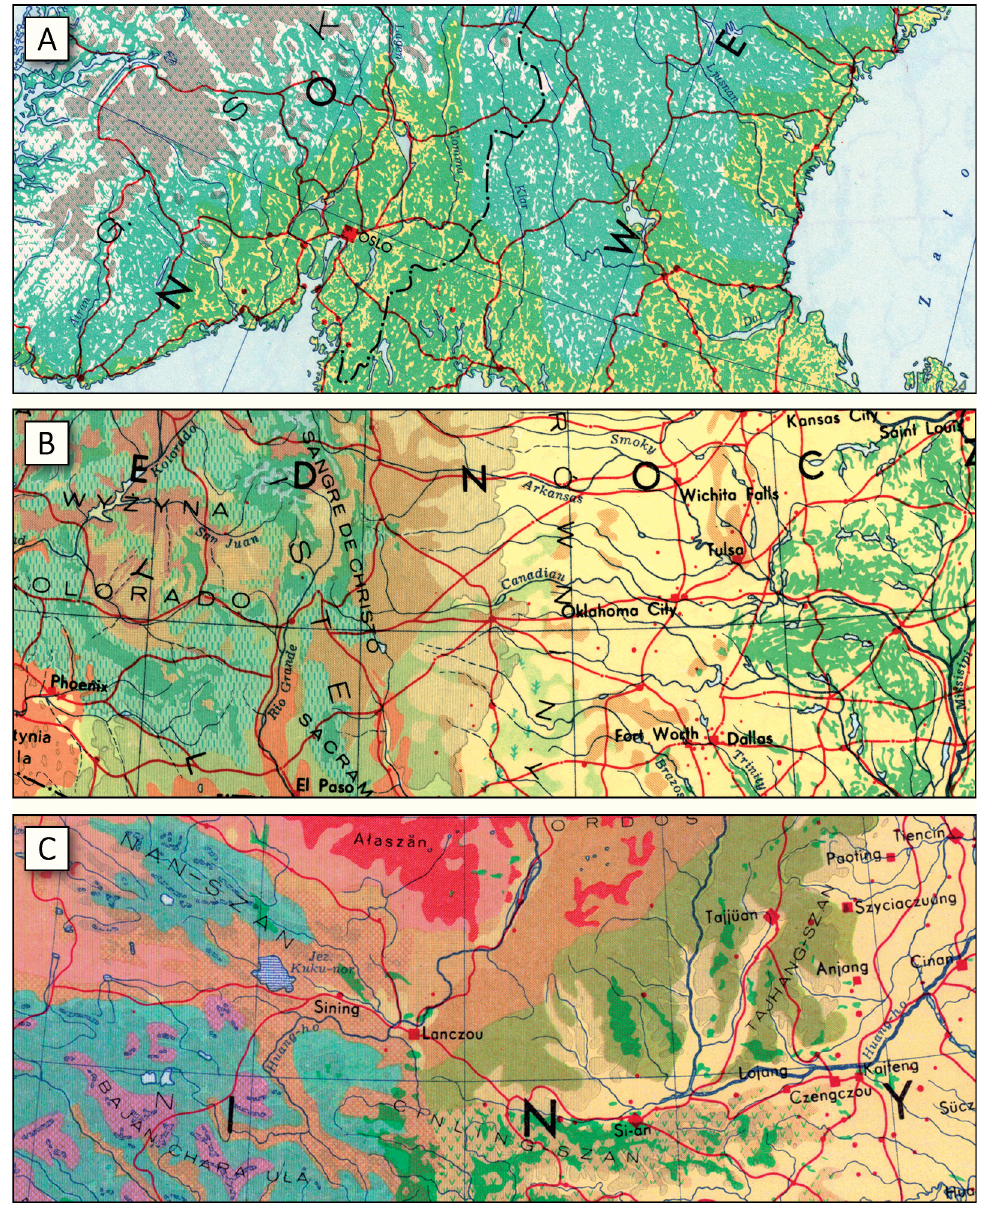
Fig. 1. Differences in generalization of the content of landscape maps included in “Universal Geography”: A – a part of the map of Northern Europe V, scale 1:6,000,000 (volume III) , B – a part of the map of North America, scale 1:15,000,000 (volume V), C – a part of the map of Eastern Asia , scale 1:15,000,000 (volume